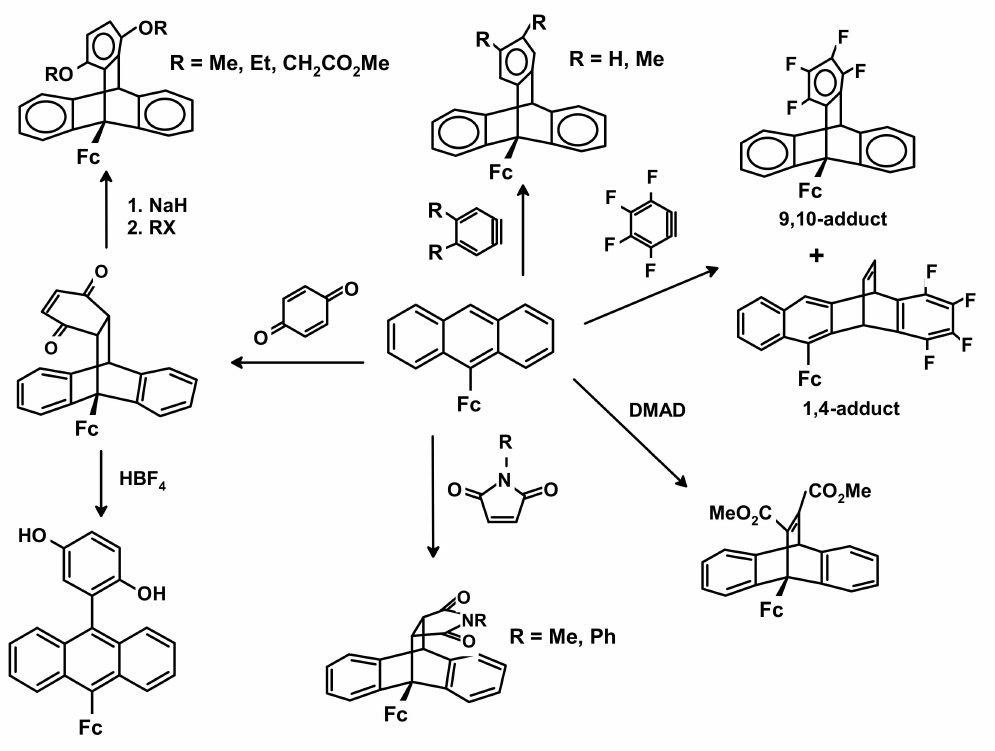
Scheme 15. Selected cycloaddition reactions to